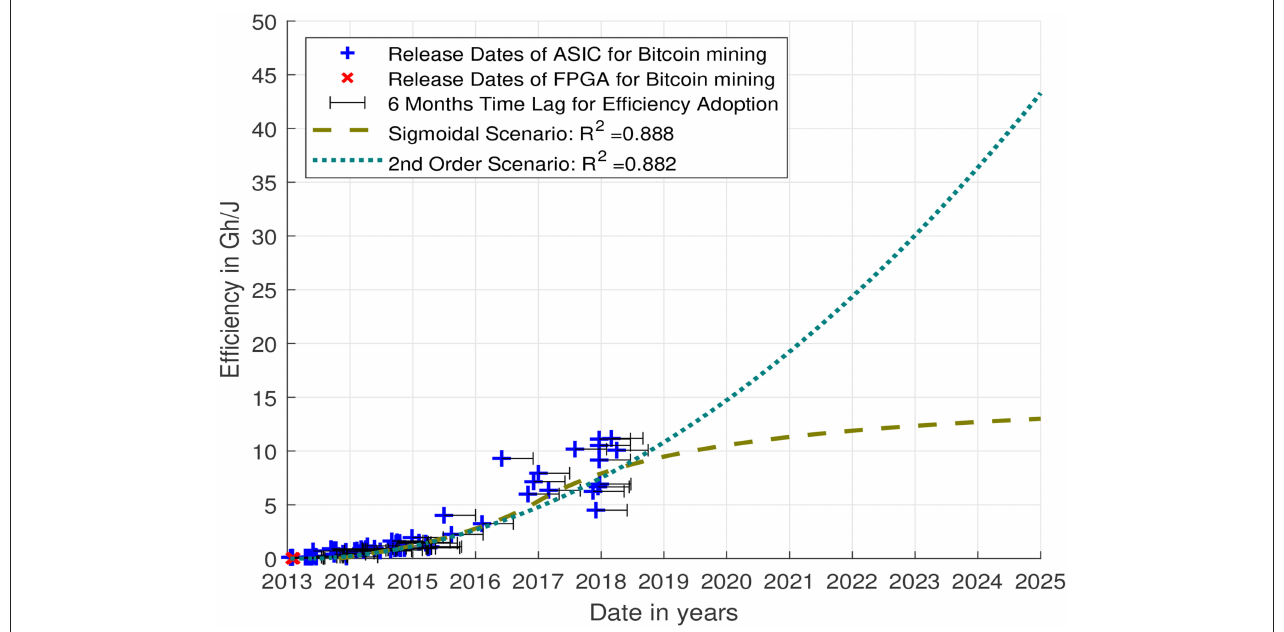
FIGURE 4 | Quadratic and sigmoid scenario for the development of the Bitcoin mining hardware efficiency fitted to the past development. Data for the hardware release dates from Zade and Myklebost (2018).